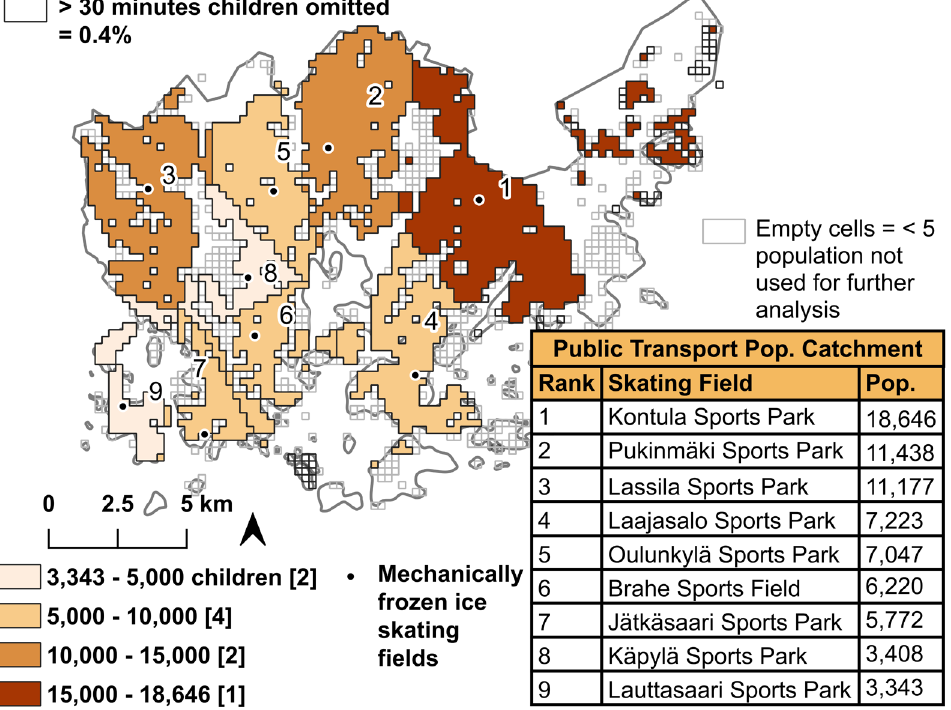
Sports Park (8.1%), and the smallest are Käpylä Sports Park (3.2%) and Lauttasaari Sports Park